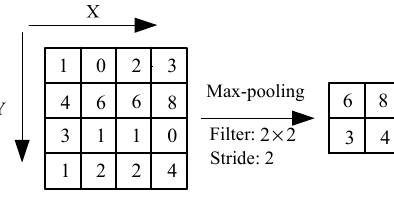
Figure 5. Principle of max-pooling.